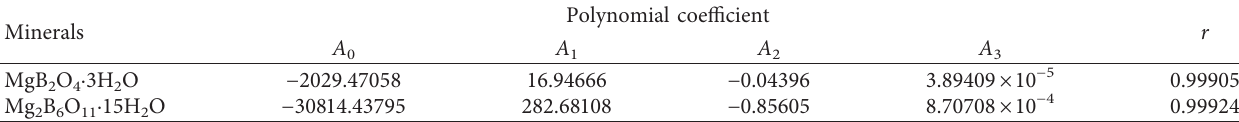
Table 4: Molar heat capacities and thermodynamic functions ( H